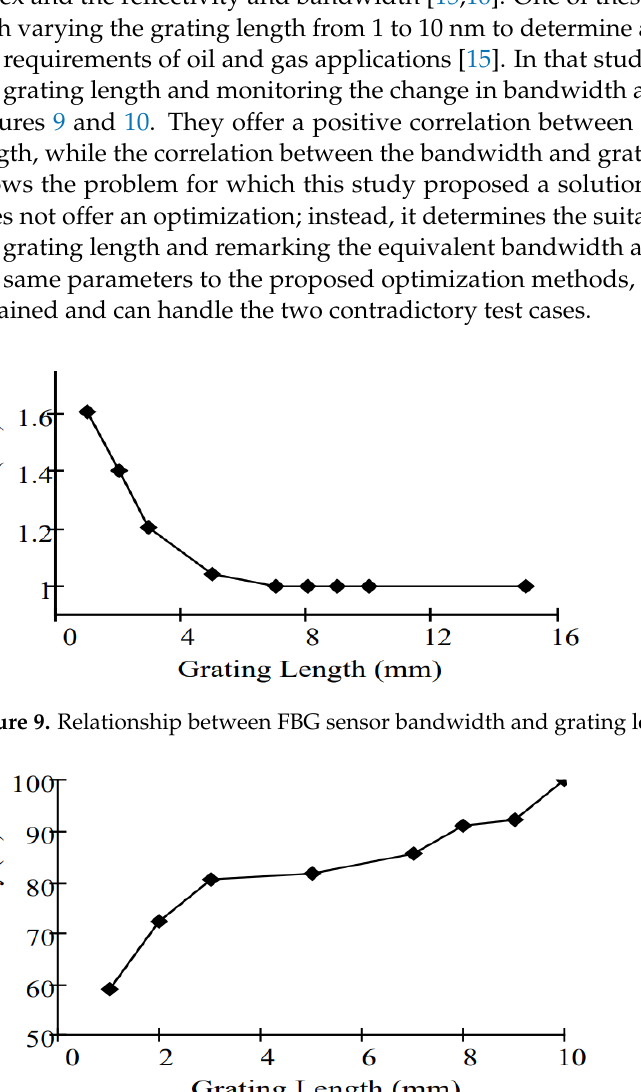
Figure 11. Relationship between FBG sensor bandwidth and grating length [16].